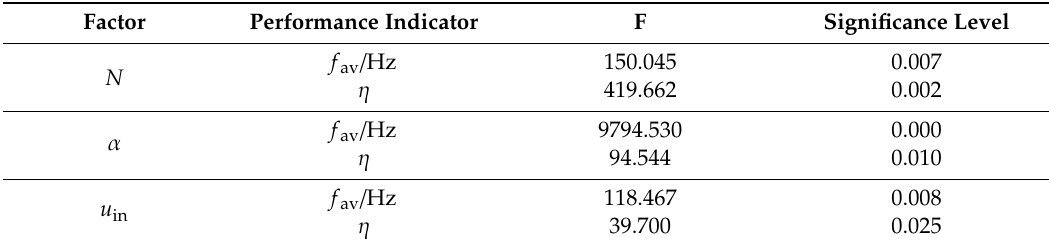
Table 3. Significance tests for the tubular PBR with spiral ribs.